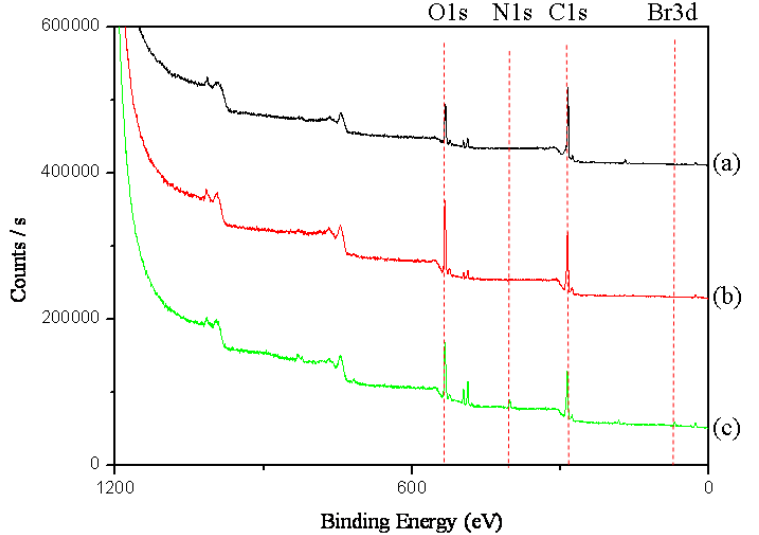
Figure 2. XPS survey scan spectra of pure MWNT (a), poly(GMA)-g-MWNT (b) and MWNT ionic liquid